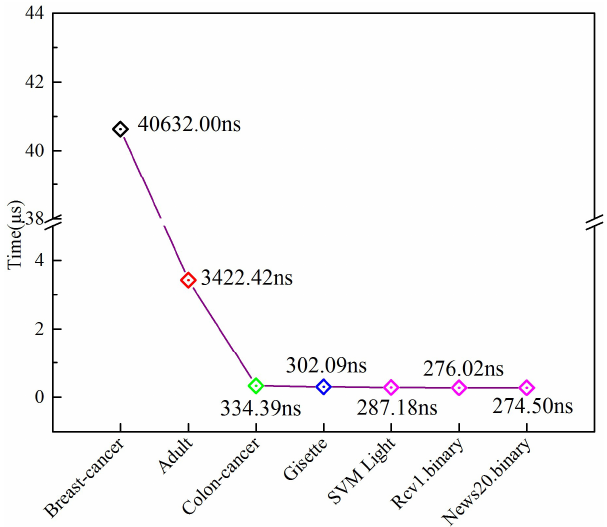
Figure 13. Proportion of time and dimension with different data sets.